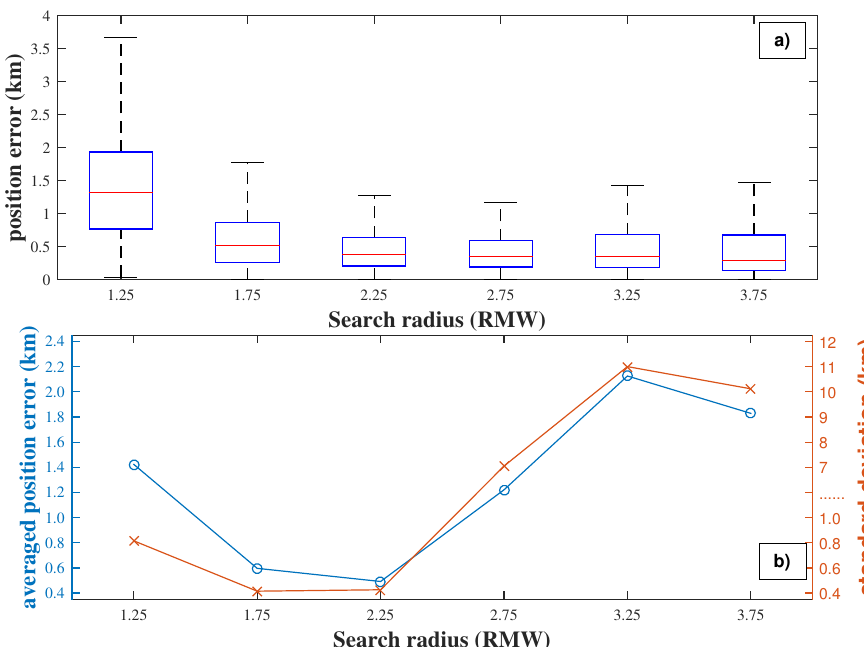
Figure 4. The statistics of position error according to normalized searching radius. ( a ) the boxplot of position error. ( b ) the group averaged position error (blue line and circles) and standard deviation (red line and crosses) in each